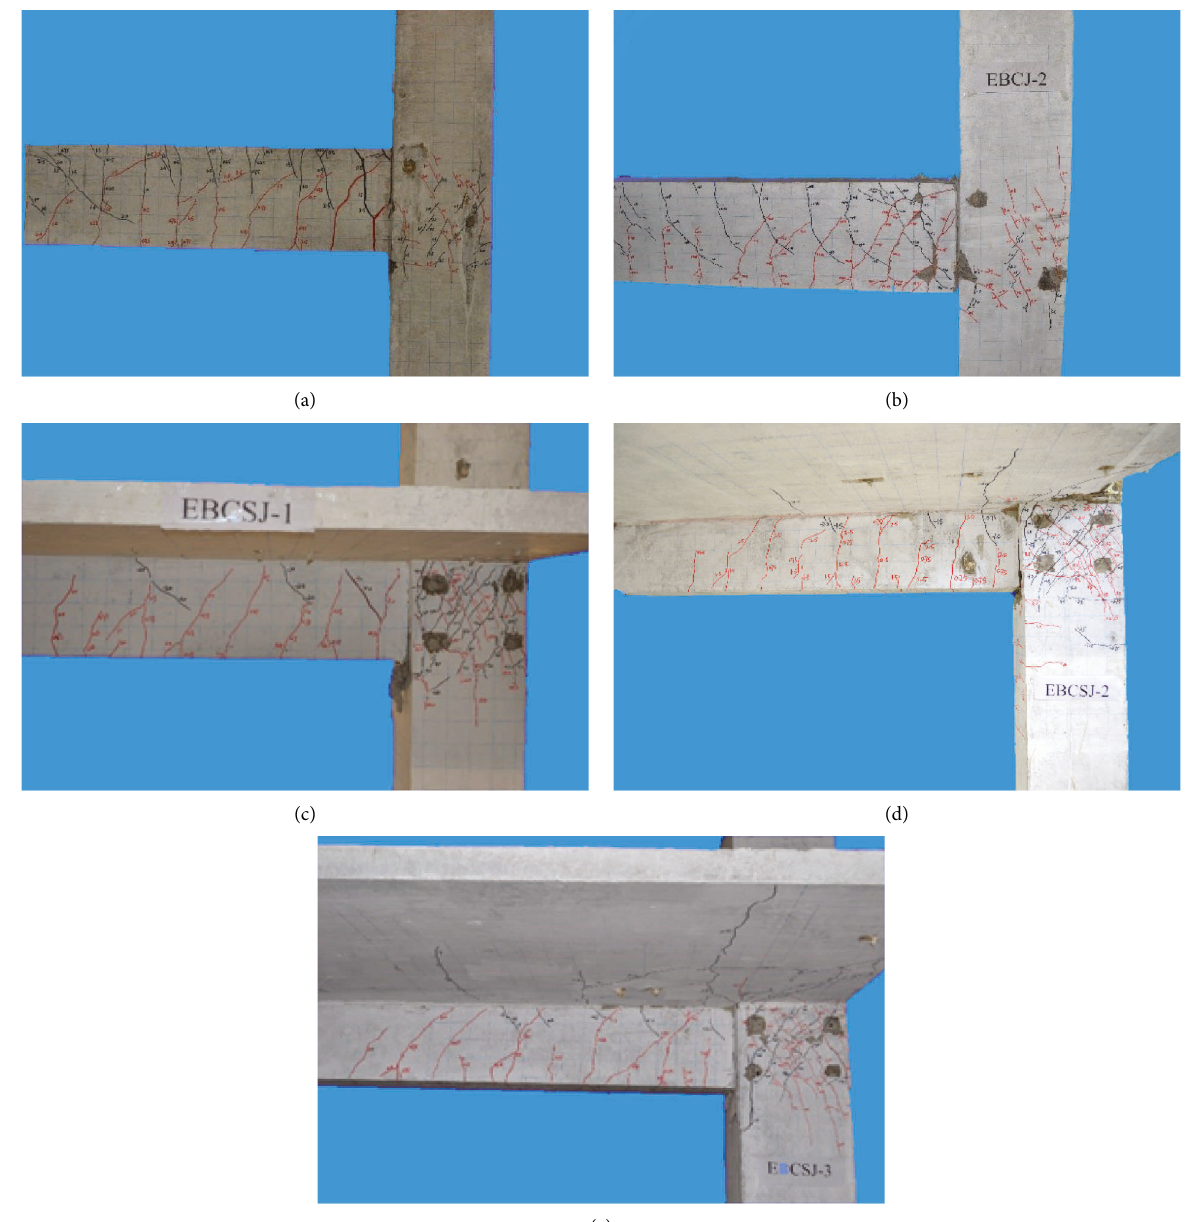
Figure 5: Failure mode of exterior joints. (a) EBCJ1. (b) EBCJ2. (c) EBCSJ1. (d) EBCSJ2. (e)